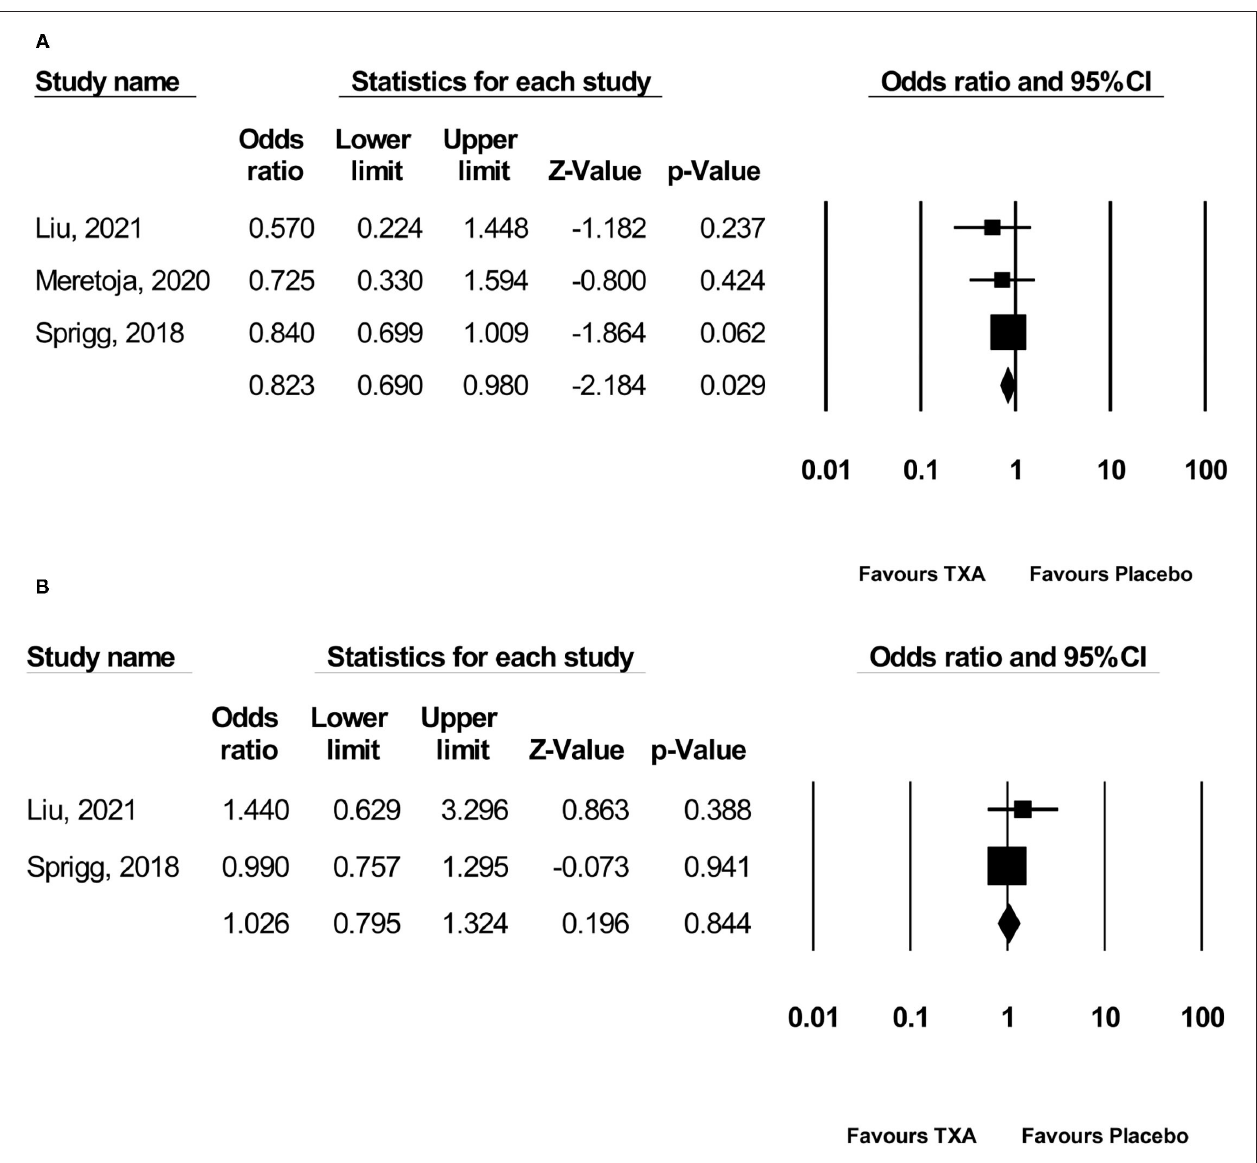
FIGURE 5 | Subgroup analysis of primary outcome measurement: (A) ≤ 4.5h and (B) > 4.5h. TXA, tranexamic